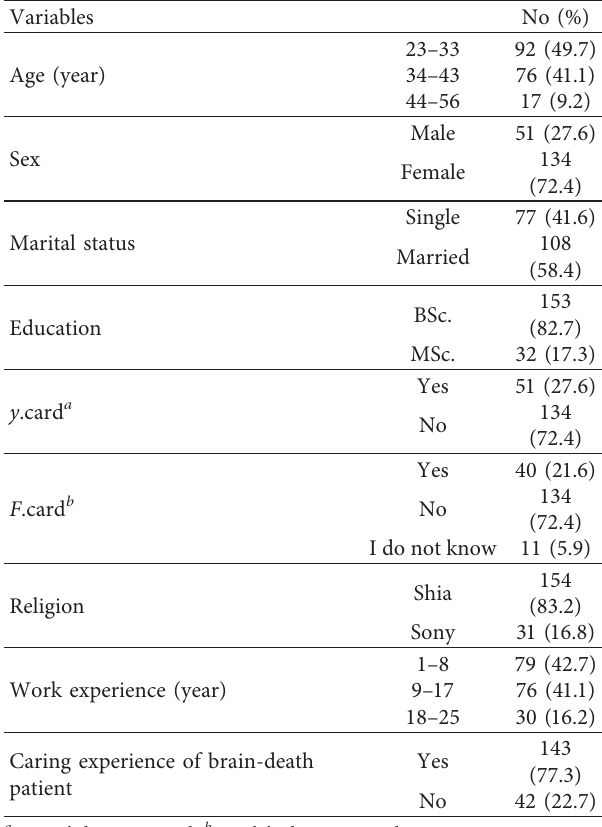
Table 1: Demographic characteristics of nurses ( n �